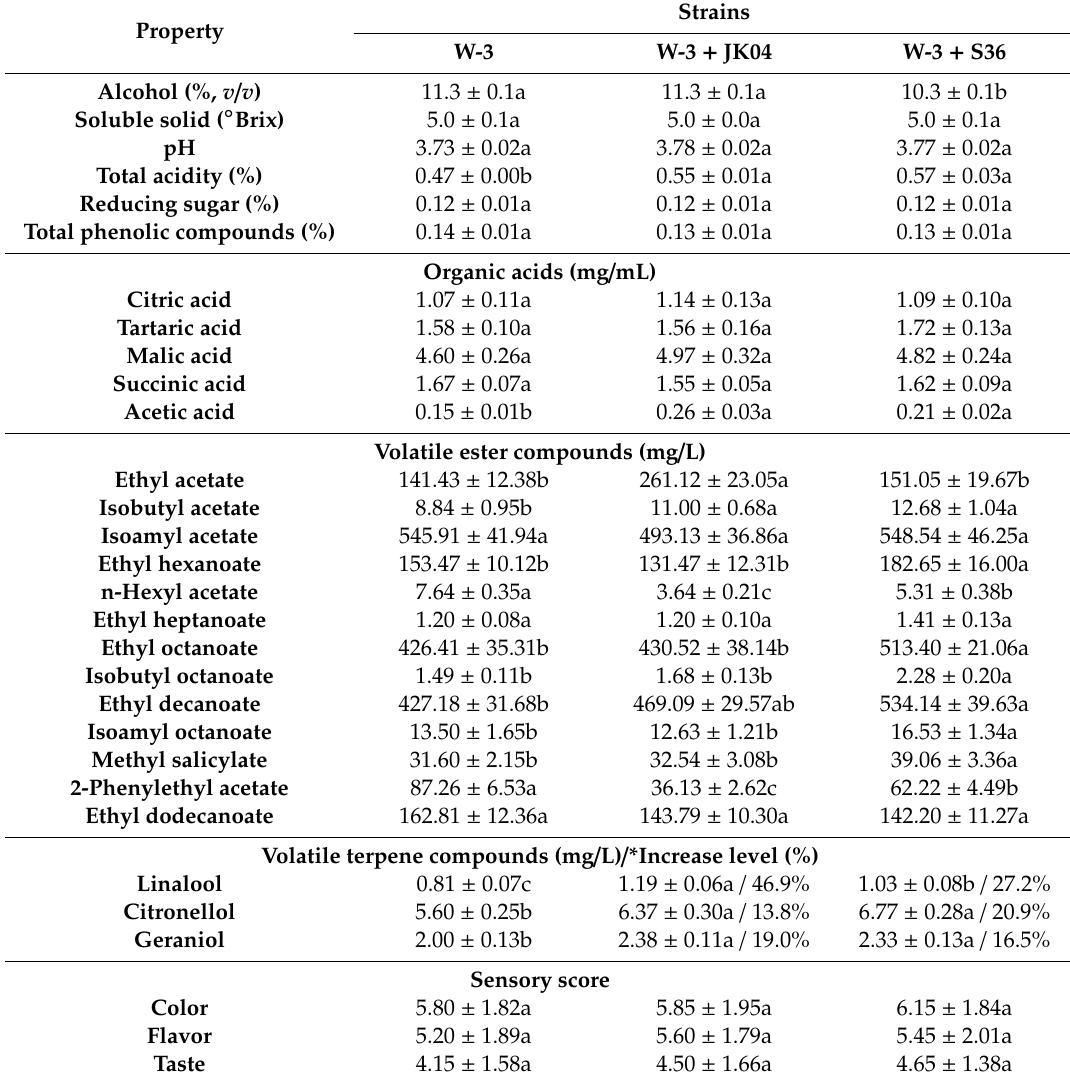
Table 4. Physicochemical properties and sensory scores of MBA wine fermented with co-cultures of S. cerevisiae W-3 (W-3) and non- Saccharomyces